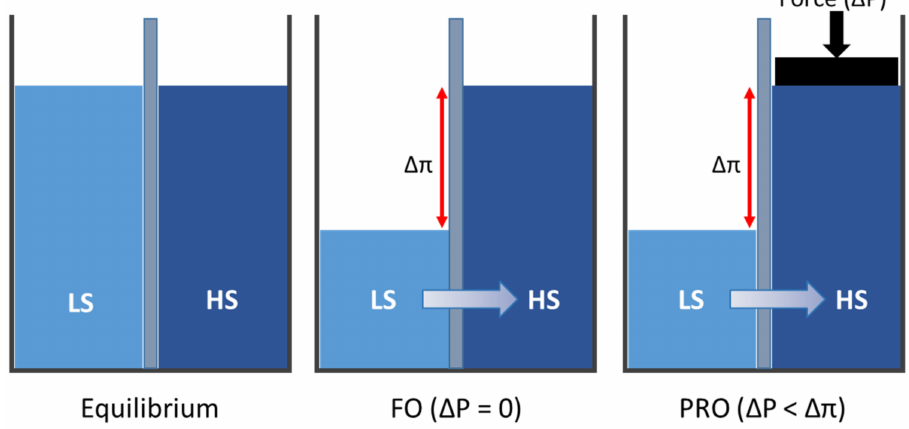
Figure 1. Comparison of FO and PRO processes. In PRO, a semipermeable membrane is used to separate the HS and LS solutions by setting the orientation of the active layer to face the draw solution (AL-DS), as shown in Figure 2. Water diffuses from the feed side with low salinity (FS-LS) into the pressurized draw solution containing the high salinity (DS-HS) solution. The pressurized and diluted draw solution then moves through a depressurizing hydro turbine to produce power [11].